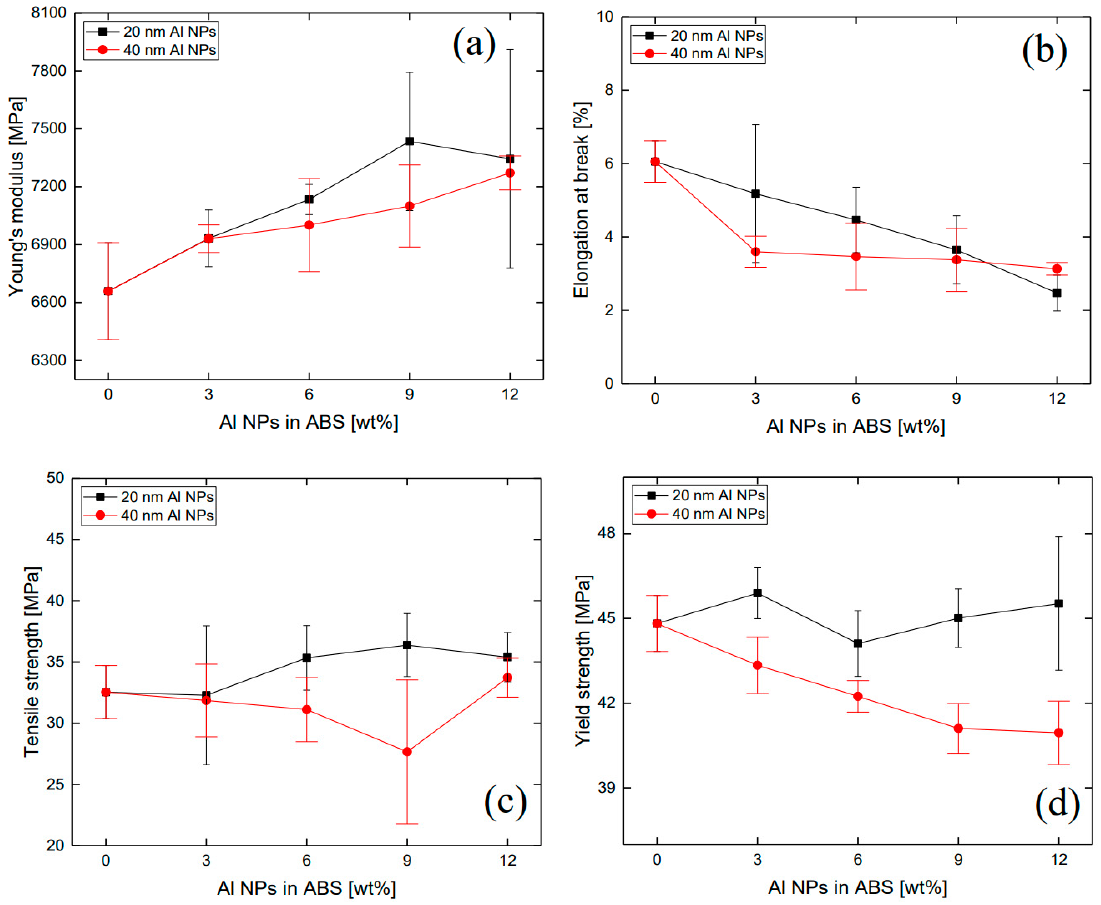
Figure 6. ( a ) Young’s modulus, ( b ) elongation at break, ( c ) tensile strength, and ( d ) yield strength results of ABS/Al composites.